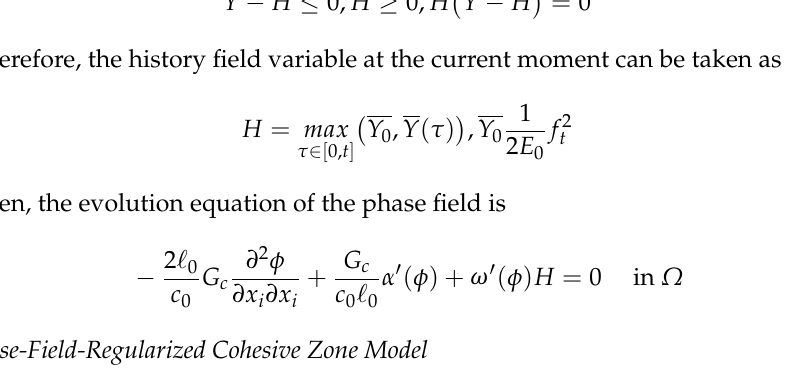
Figure 2. Schematic illustration of sharp ( 𝛤 , left) and diffusive ( ℬ , right) crack topology in a 2D solid 𝛺 with its external boundary ∂𝛺 . The external boundary ∂𝛺 can be divided into two parts: ∂𝛺 (cid:3047) and ∂𝛺 (cid:3048) , with ∂𝛺 (cid:3047) ∩ ∂𝛺 (cid:3048) = ∅ and ∂𝛺 (cid:3047) ∪ ∂𝛺 (cid:3048) = ∂𝛺 , in which it is given displacements 𝒖 ∗ for ∂𝛺 (cid:3048) and tractions 𝒕 ∗ for ∂𝛺 (cid:3047) , respectively. The outward unit normal vector of external boundary ∂𝛺 is denoted as 𝒏 .